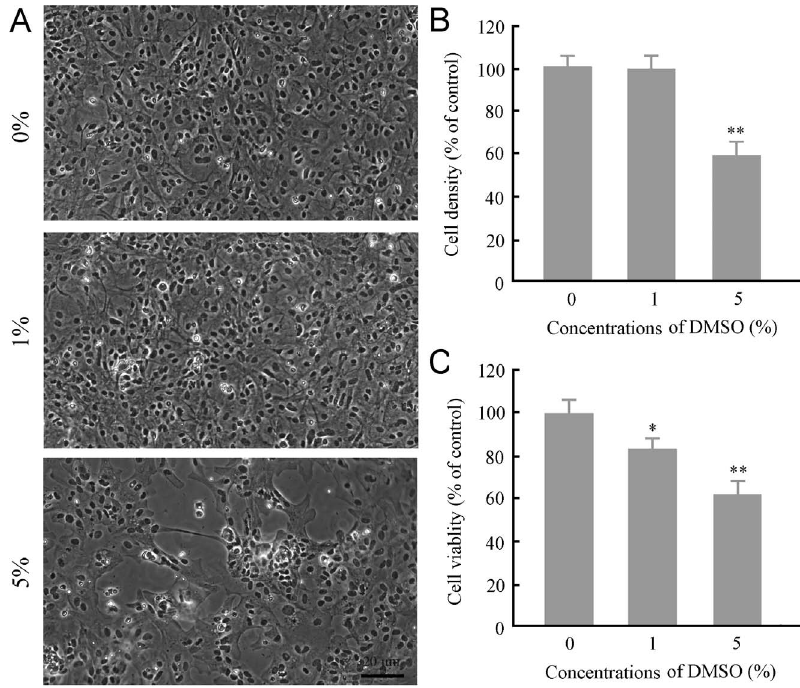
Figure 1. Effects of DMSO on survival and viability of mouse cortical astrocytes in culture. ( A ) General growth profile of incubated with various concentrations of DMSO for 24 h. Astrocytes were grown well and closely adhered to each other on the surface of coverslips under normal circumstances and exposed to 1% DMSO. Many astrocytes were detached from the coverslips in 5% DMSO culture medium. ( B–C ) Quantitative analysis of the cell density (B) and cell viability (C) of astrocytes incubated with different concentrations of DMSO for 24 h. Data are shown as a mean 6 SEM of five independent experiments performed in triplicate. * P , 0.05 and ** P , 0.01 versus control group.